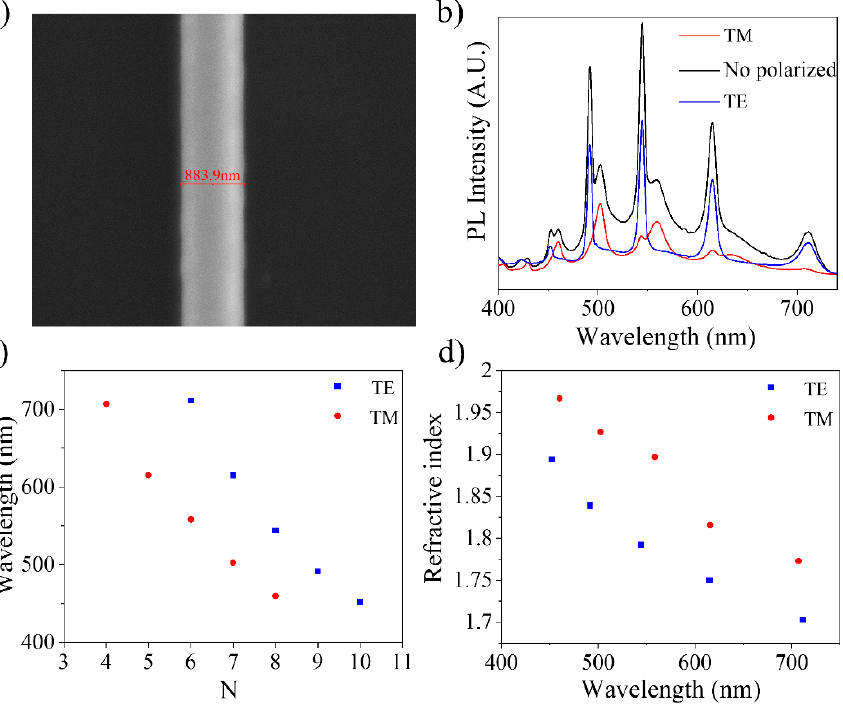
Figure 12. Analysis of structures as resonant cavities in ZnO:K. ( a ) Electron micrograph of the hexagonal structure with a width of 883.9 nm. ( b ) Photoluminescence spectrum with the total component and polarized components. ( c ) Calculation of the interference order and ( d ) the refractive index as a function of